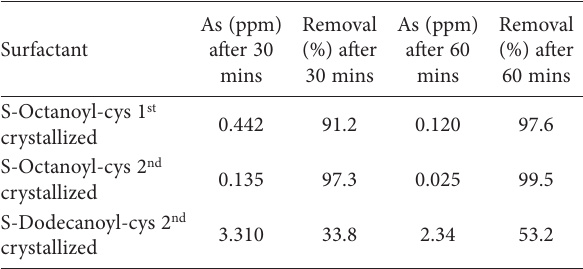
Table 1. Ion flotation results for the removal of arsenic ions (5 mg/L or ppm) at pH = 8 using different cysteine-based surfactants (reproduced from 15 ). C(surfactant) = 0.01M.